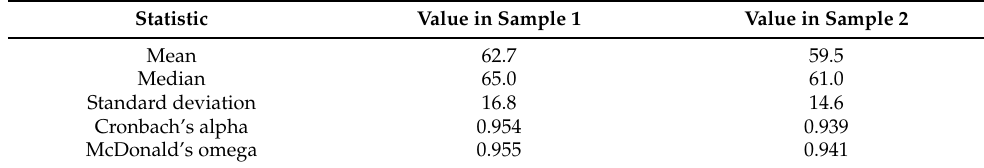
Table 4. Characteristics of the scores in the DSES comprising all 16 items, Cronbach’s alpha and McDonald’s omega internal consistency coefficient according to the univariate model in both